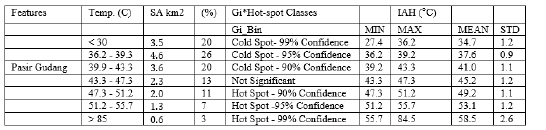
Table 10. The percentage coverage area of Getis-Ord Gi* Hot- spot classes with relative average values of IAH